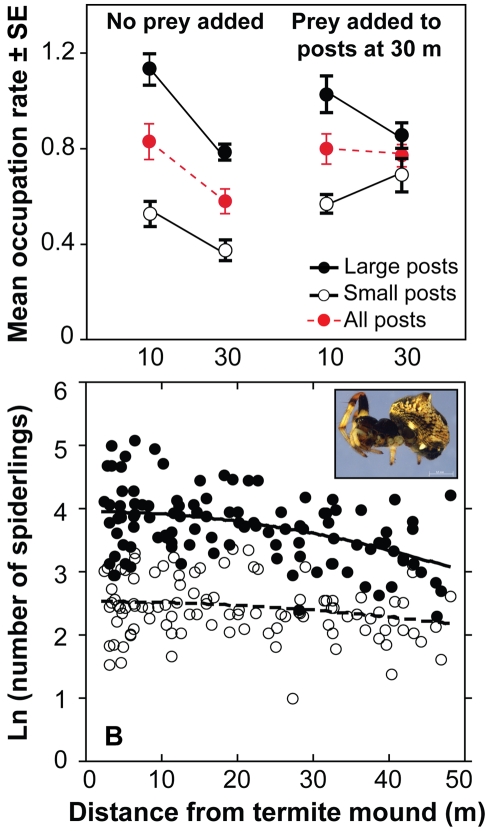
Termites' effects on arboreal predators.(A) Gecko habitat-selection experiment (repeated-measures MANOVA main effects: post size F
1,33 = 95.9, p<0.0001; mound proximity F
1,33 = 11.0, p = 0.002). Experimental prey supplementation at 30 m essentially equalized mean occupation rates at 10 m and 30 m (red markers; time × proximity interaction: F
1,33 = 7.5, p<0.01; Table S3). (B) Fecundity of female Cyclosa sp. (inset) decreases as a function of mound-proximity squared. Statistical significance of mound proximity determined using multiple regression with female carapace width as a covariate (N = 102). For total offspring per female (solid circles): F
1,99 = 21.9, p<0.0001. For mean number of offspring per egg sac per female (open circles): F
1,88 = 5.1, p = 0.026.